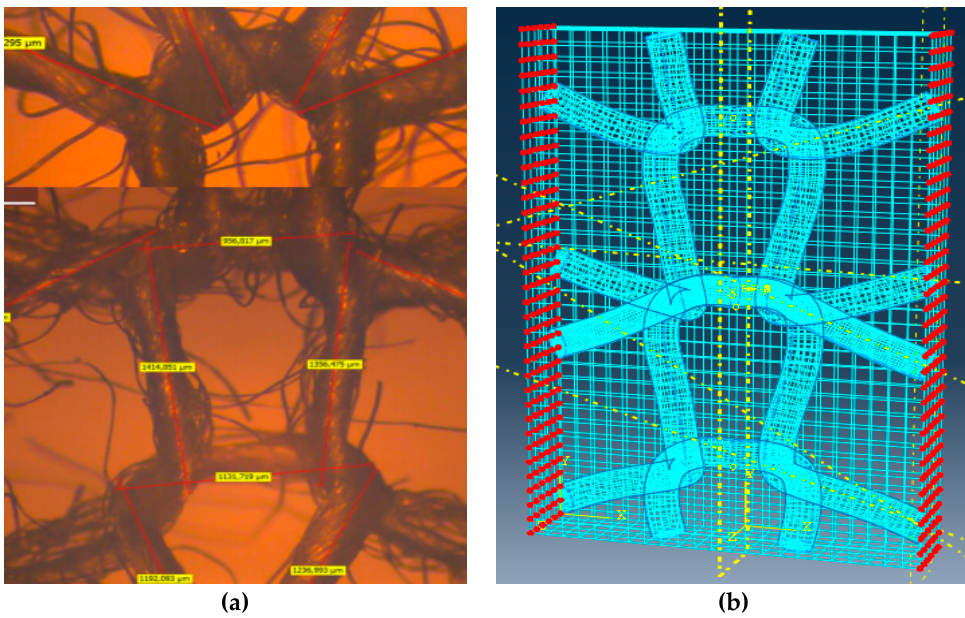
Figure 6. Periodic boundary conditions.